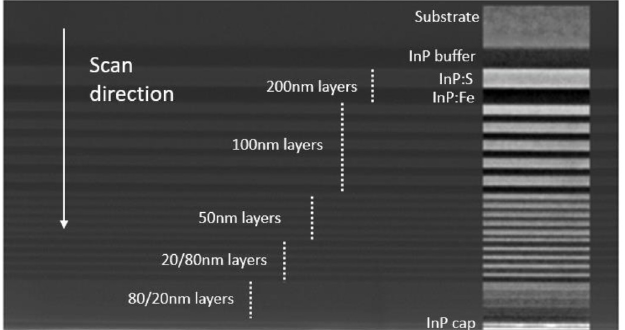
Fig. 1. SEM image of the InP:S and InP:Fe sample surface. The image was edited to highlight with the gray and black color the InP:S and InP:Fe layers, respectively. The fi rst two layers represent the substrate and the nid